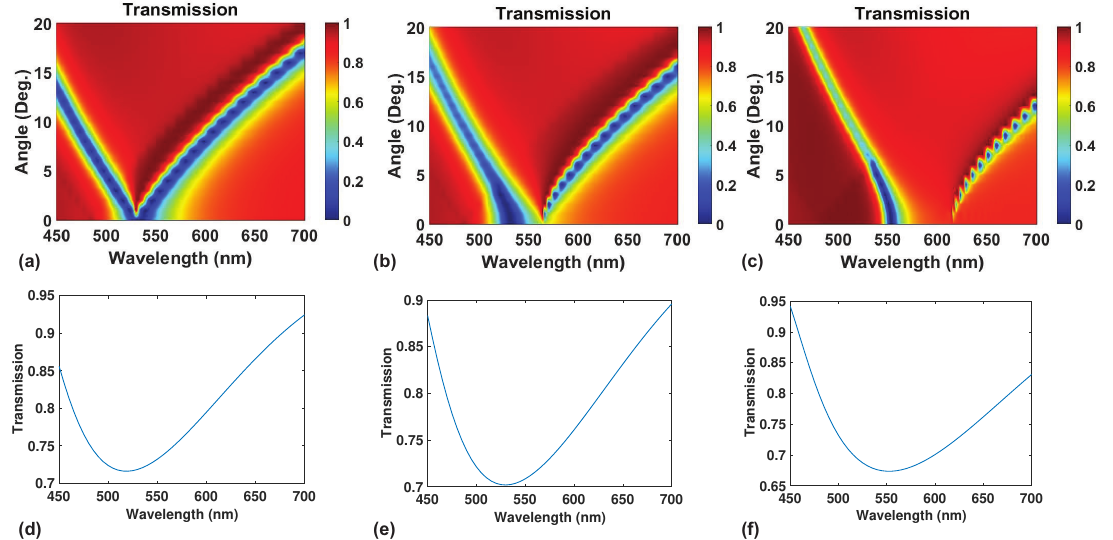
Figure 5. Transmission versus angle plots for different fill fractions of ( a ) 0.4, ( b ) 0.5 and ( c ) 0.7. The corresponding transmission versus wavelength at zero incidence are calculated using effective medium theory (EMT) for the same set of fill fractions of ( d ) 0.4, ( e ) 0.5 and ( f ) 0.7. EMT is able to describe the positions of maximum transmission at zero angle as shown in ( a – c